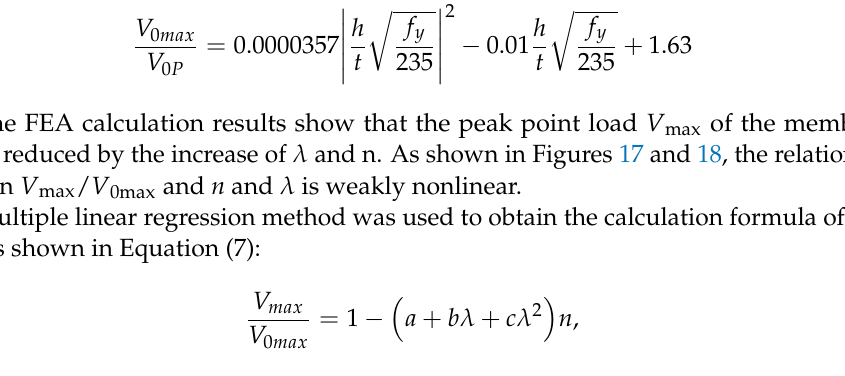
Figure 16. The effect of h / t on V 0 max / V 0P .